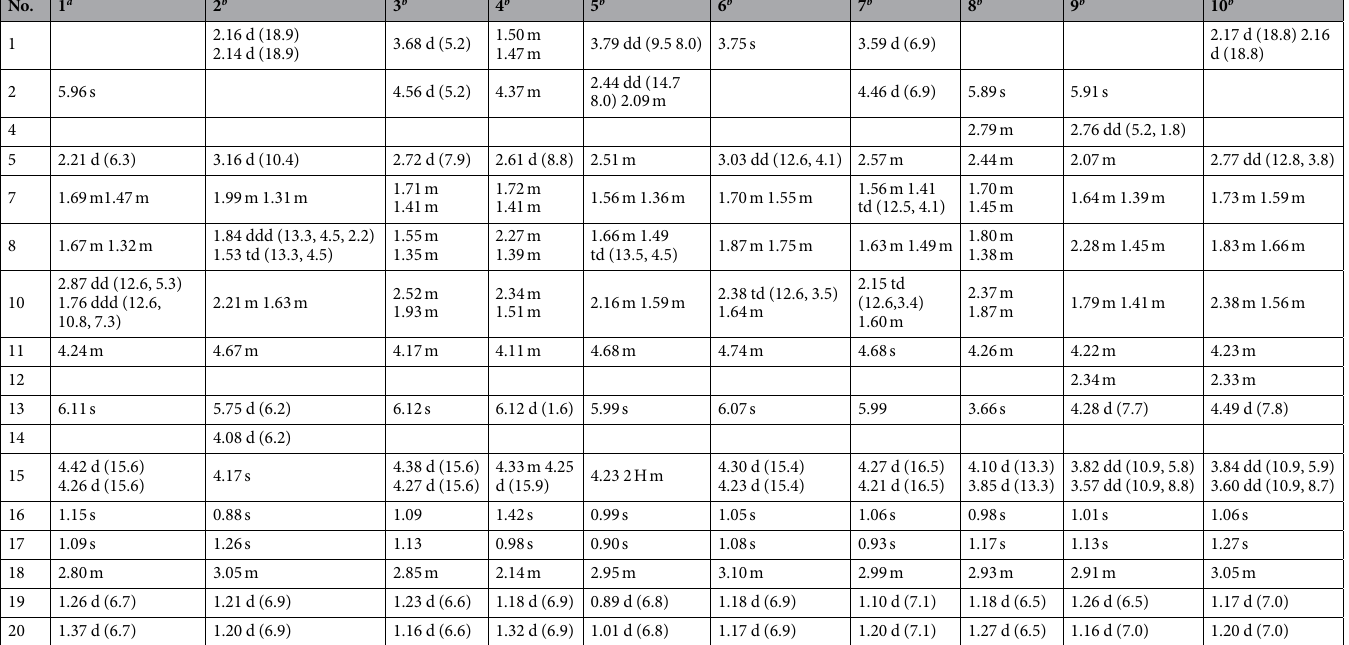
Table 1. 1 H NMR Spectroscopic Data for Compounds 1–10 in MeOH- d 4 . a 800 MHz. b 500